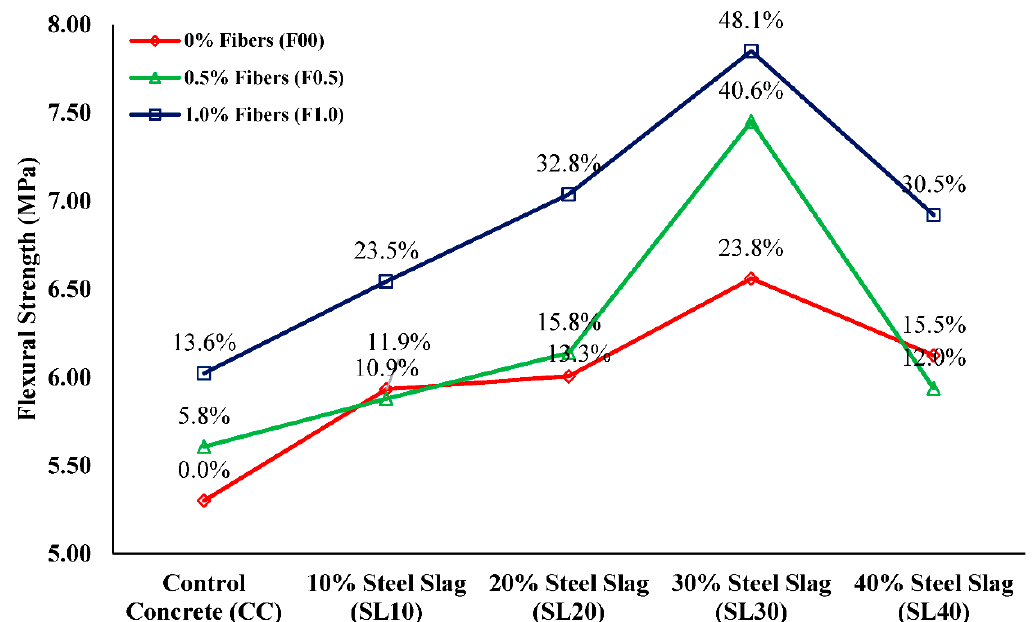
Figure 7. Flexural strength results of all concrete mixes.